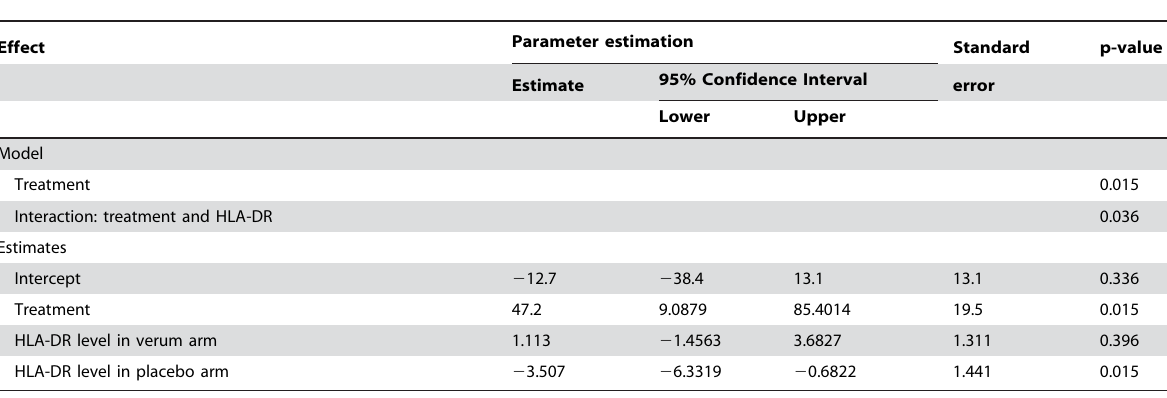
Table 6. Logistic regression analysis of independent predictors for post-stroke infections